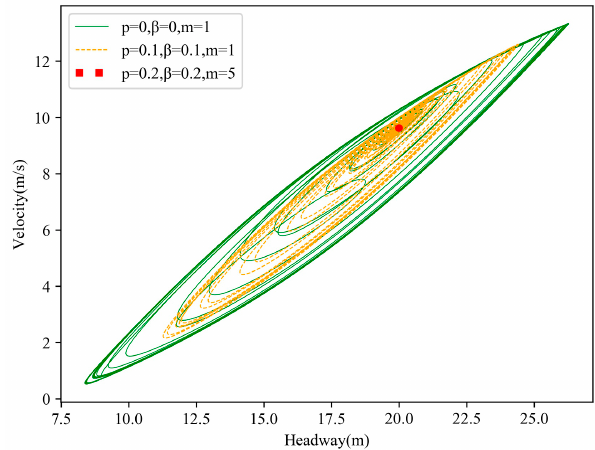
Figure 6. Hysteresis loops of traffic flow.